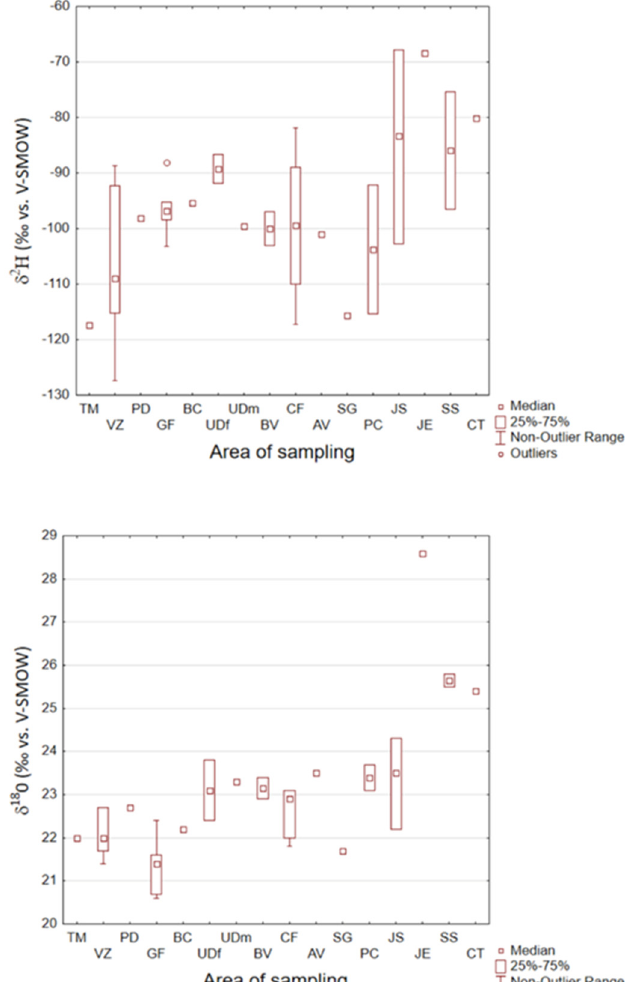
Figure 3. Box-plots of δ 2 H and δ 18 O values, expressed in ‰, of Italian industrial hemp inflorescence samples ( Cannabis sativa L.) ordered according to the latitude of the sampling areas (from the highest to the lowest). V-SMOW = Vienna-Standard Mean Ocean Water, TM = Tolmezzo (UD), VZ = Verzegnis (UD), PD = Predaia (TN), GF = Gemona del Friuli (UD), BC = Baceno (VB), UD = Udine ( f = grown under synthetic fertilization, m = grown under bovine manure fertilization), BV = Borgo Valbelluna (BL), CF = Campoformido (UD), AV = Altopiano della Vigolana (TN), SG = Seren del Grappa (BL), PC = Piacenza, JS = Jolanda di Savoia (FE), JE = Jesi (AN), SS = Sassari, CT = Caltagirone (CT).